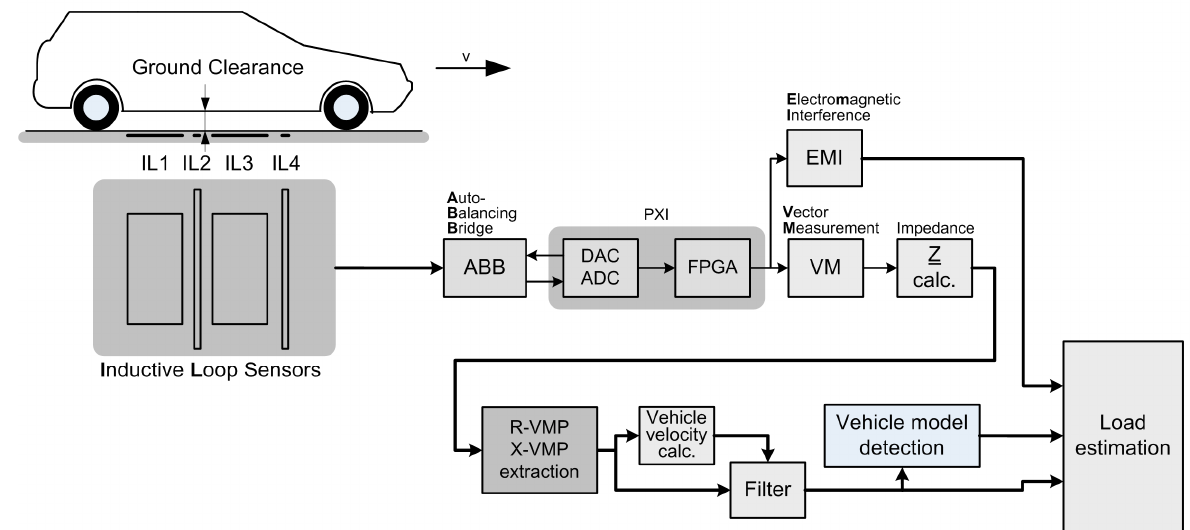
Figure 1. Load estimation system block diagram. IL1—the first standard IL sensor, IL2—the first slim IL sensor, IL3—the second standard IL sensor, IL4—the second slim IL sensor. Each IL sensor has its own impedance parameter measurement channel. Impedance measurement is carried out using the auto-balancing bridge method (ABB). The system includes four processing channels dedicated to four IL sensors. Digital processing is car- ried out using an industrial NI-PXI computer with a data acquisition card containing an FPGA module. Detailed technical information about the IL sensors construction and the implementation of the MFIM method is given in [24]. Compared to [24], the following significant changes have been additionally applied. Currently we use a new set of excita- tion frequencies, listed in Table 1, for obtaining R-VMP and X-VMP. Table 1. The list of excitation frequencies applied in the system. Frequency Value in kHz in a Given Channel: f1 f2 f3 #1: for the first standard IL1 sensor